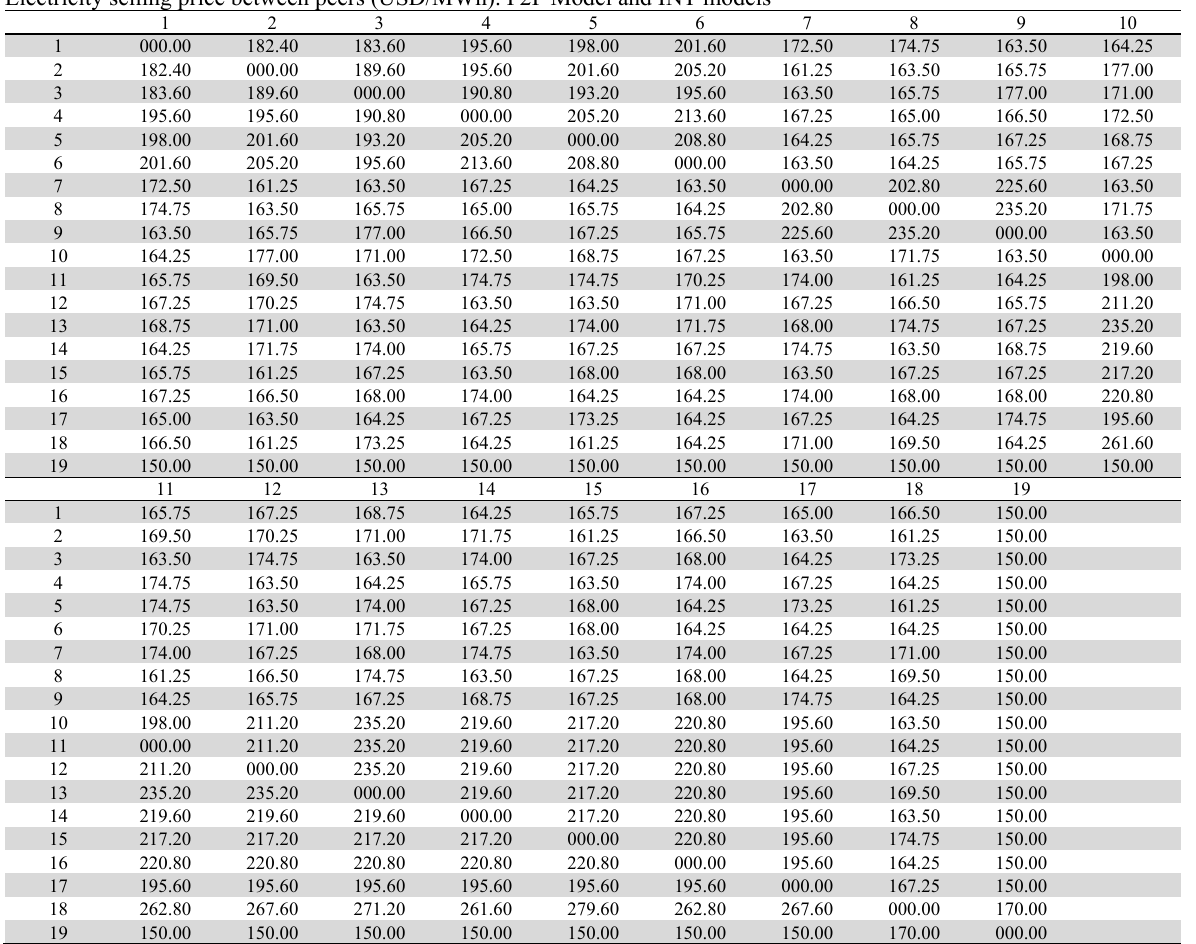
Electricity selling price between peers (USD/MWh). P2P Model and INT